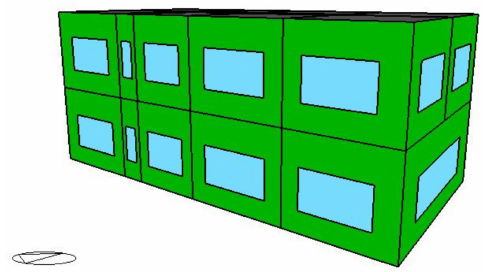
Figure 2. Tridimensional model of the o ffi ce